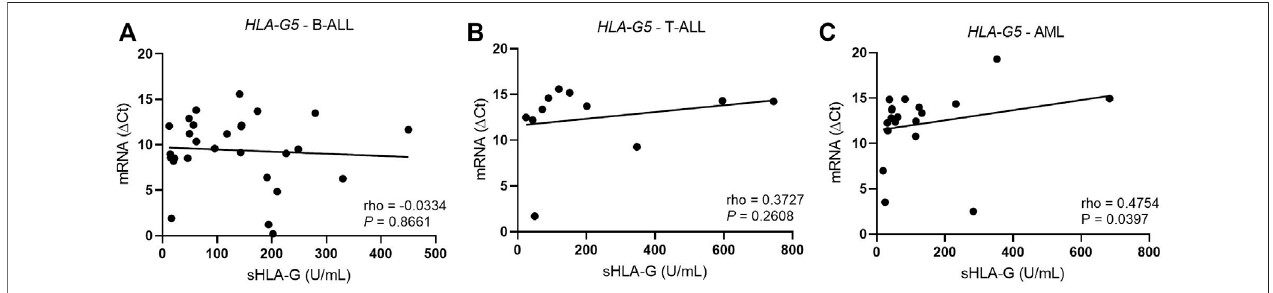
FIGURE 6 | Correlation coef fi cient analysis between HLA-G5 mRNA and sHLA-G levels in the bone marrow from patients with untreated leukemia. (A) Correlation coef fi cient analysis between HLA-G5 and sHLA-G in B-ALL ( n = 28); (B) correlation coef fi cient analysis between HLA-G5 and sHLA-G in T-ALL ( n = 11); and (C) correlation coef fi cient analysis between HLA-G5 and sHLA-G in AML ( n = 19). For the correlation analysis, the Spearman ’ s correlation coef fi cient was